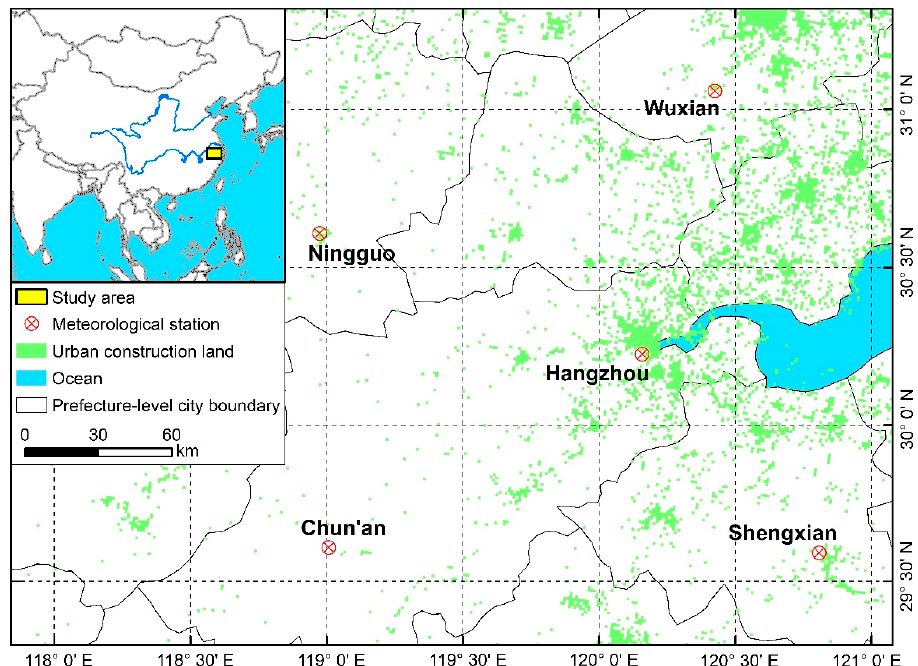
Figure 1. Locations of the five meteorological stations near Hangzhou City, China.